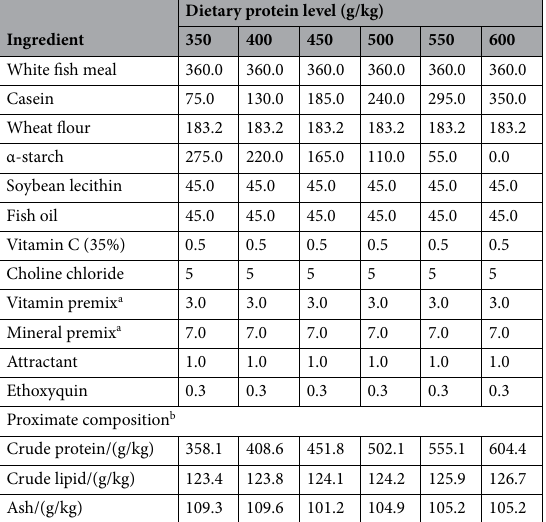
Table 4. Formulation and proximate composition of the experimental diets (g/kg dry matter). a Vitamin and mineral premix were obtained from Qingdao Master Biotechnology Co, Ltd (Qingdao, China). b Measured